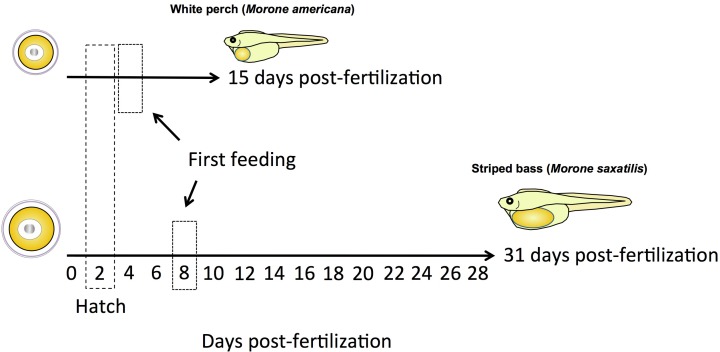
Average survival duration of food-restricted white perch and striped bass larvae.Dashed boxes indicate approximate time of hatching (~2 days) and onset of first feeding (~4 days in white perch, ~8 days in striped bass). [Mansuetti, 1964; Eldridge, et al., 1981; North & Houde, 2003].